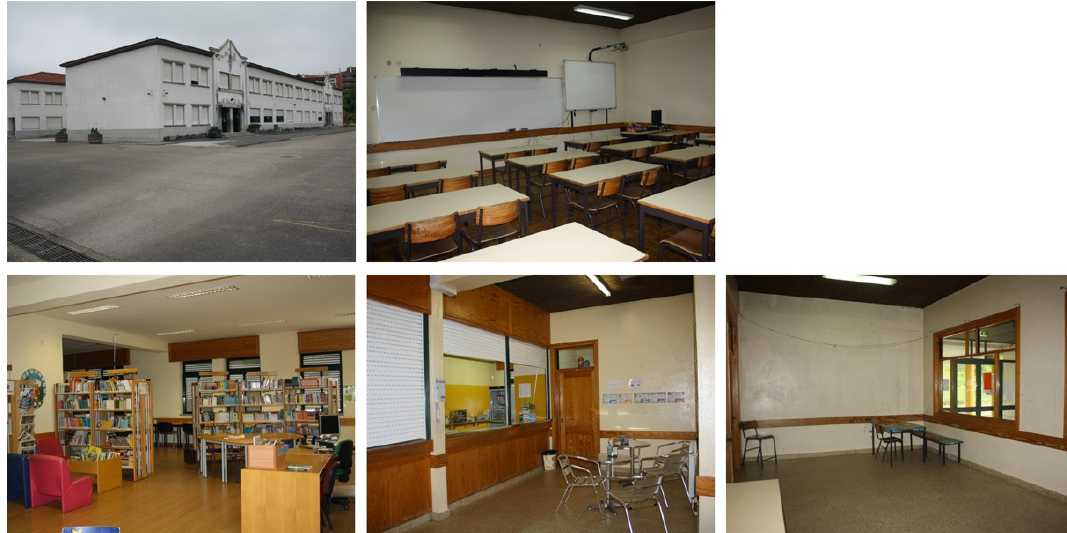
Figure 6. Escola B á sica Rainha Santa Isabel (EBRS)—photographs of the school spaces used in the questionnaire (from left to right and from top to bottom: outdoor spaces; formal learning spaces; study spaces; eating spaces, and passageways and